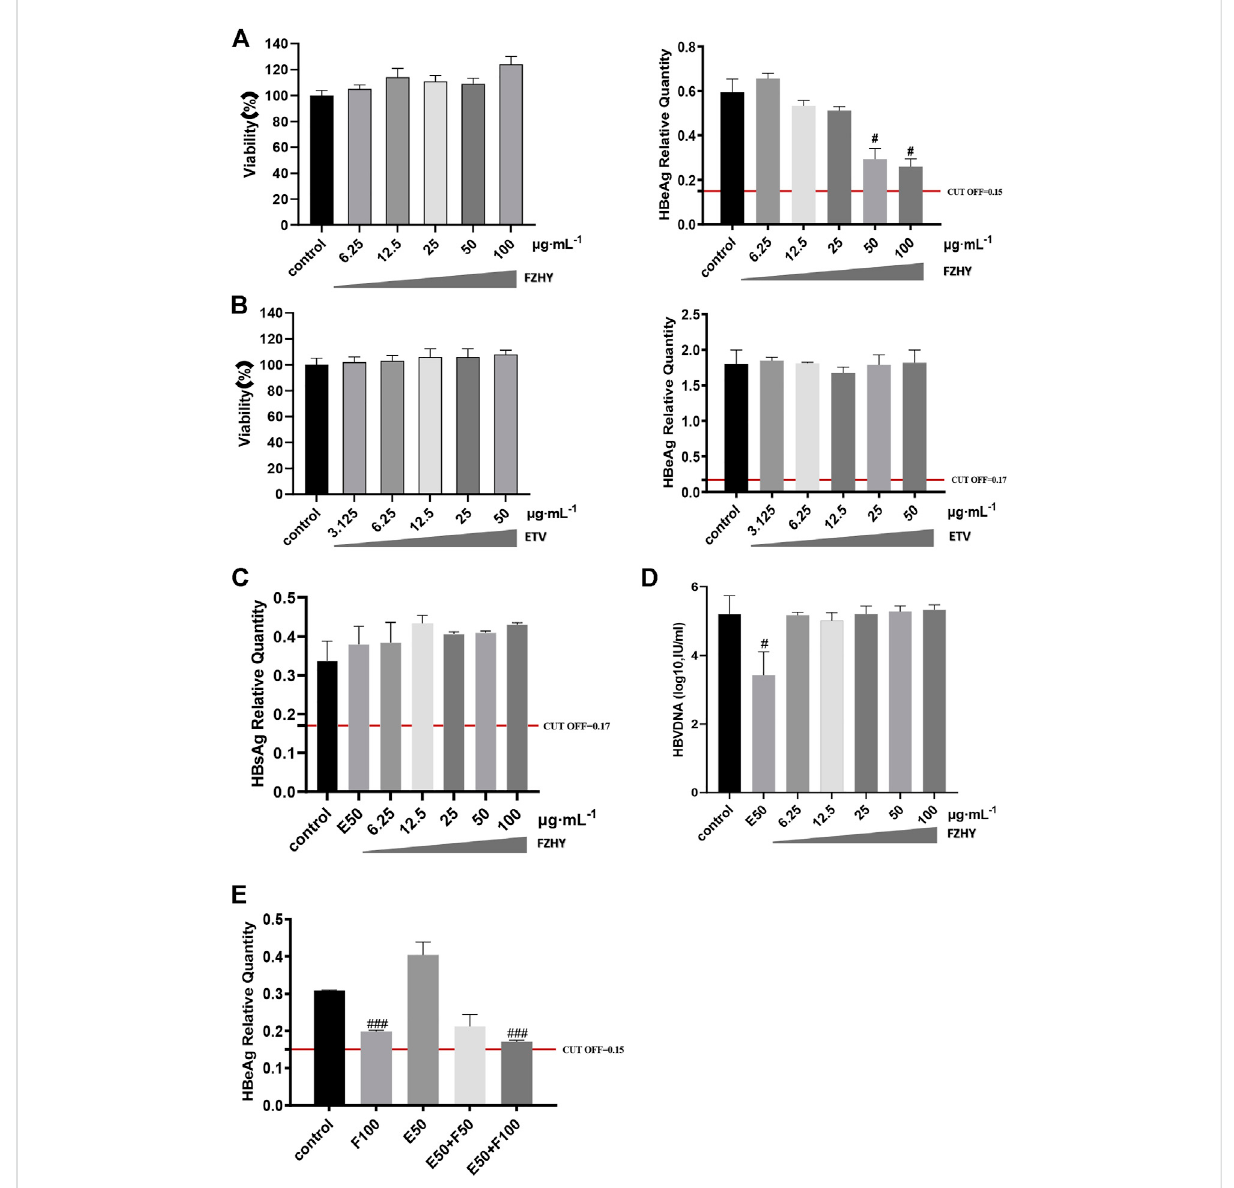
FIGURE 3 Cytotoxicity of FZHY on HepG2.2.15 cells and the effect of FZHY on the HBV expression in HepG2.2.15 cells. (A) Cytotoxicity and HBeAg production-inhibition effect of FZHY on HepG2.2.15 cells; (B) Cytotoxicity and HBeAg production-inhibition effect of ETV on HepG2.2.15 cells; (C) Effectof50 μ g/mlETV(E50)andvariousconcentrationsofFZHYonHBsAgproduction; (D) Effectsof50 μ g/mlETV(E50)andvariousconcentrations of FZHY on HBV-DNA production; (E) Effect of 50 μ g/ml ETV (E50) combined with 50 or 100 μ g/ml FZHY (F50 or F100) on HBeAg production. Each group vs. control group, # p < 0.05, ## p < 0.01, ### p <